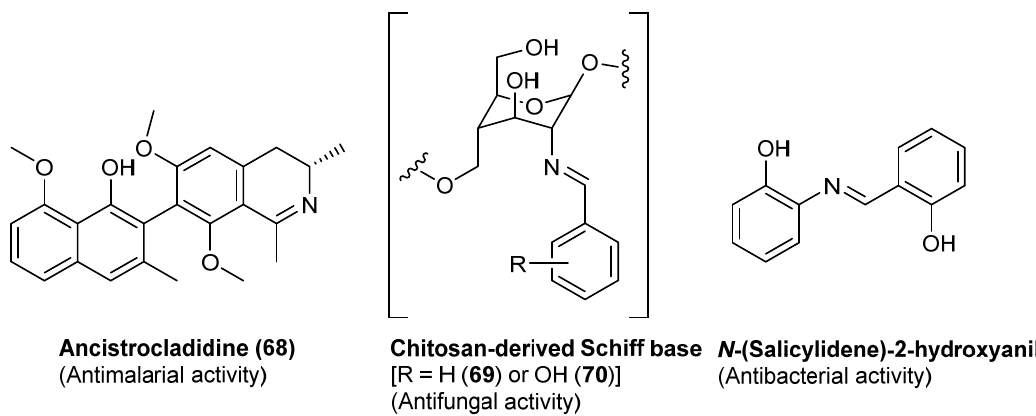
Figure 4. Some examples of biologically active Schiff